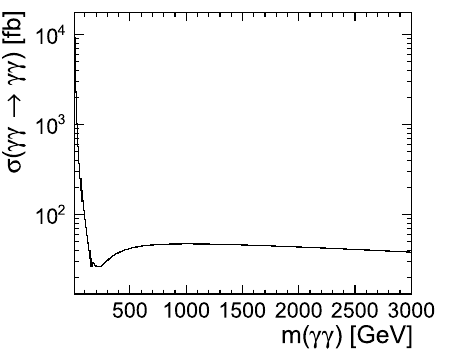
√ Fig. 2 Left panel: dependence on the centre-of-mass energy s of the except in the neighbourhoods of the W + W − and ˆ tt thresholds. The colours and numbers represent the cross-section in femtobarns in the Heisenberg–Euler cross-section calculated in the photon polar angle corresponding angular bin. Both panels were generated using the SANC region 5 o < θ γ < 175 o , showing the effects of the W + W − and ˆ tt code intermediate states. Right panel: the angular distribution in the γγ cen- √ s , displaying forward-backward peaking tre of mass as a function of